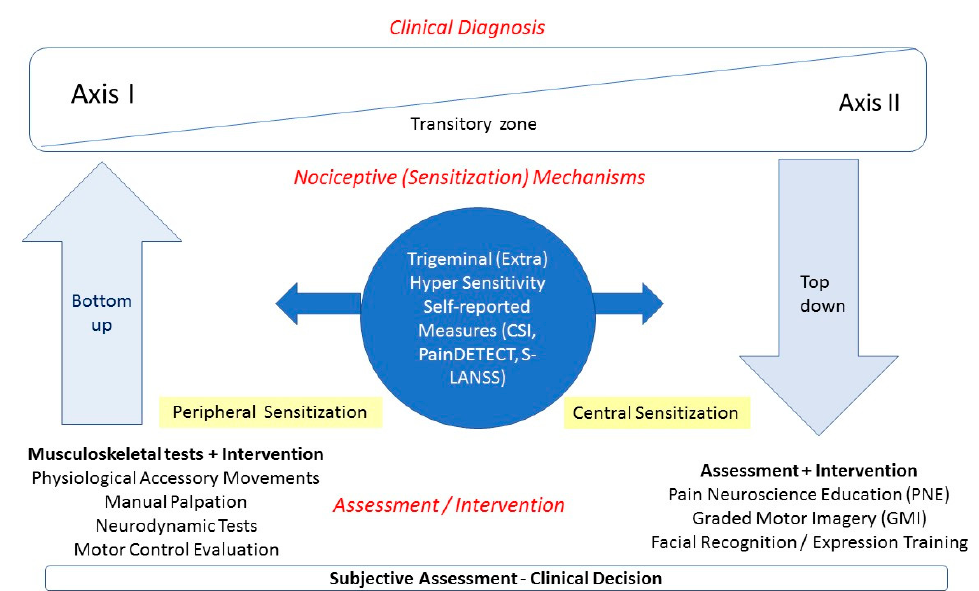
Figure 8. Algorithm for the clinical examination and treatment of patients with TMD based on nociceptive pain mechanisms.